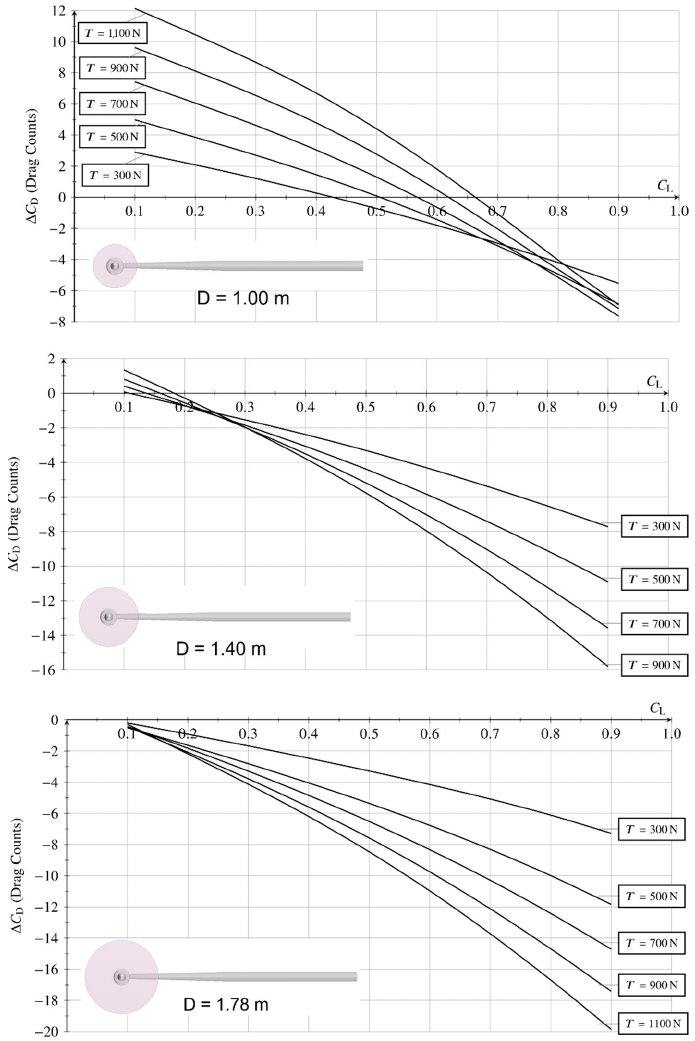
Figure 21. Drag reduction due to high-efficiency tip-propeller, AR = 8.47, M = 0.23, Re = 6.9 × 10 6 [8].